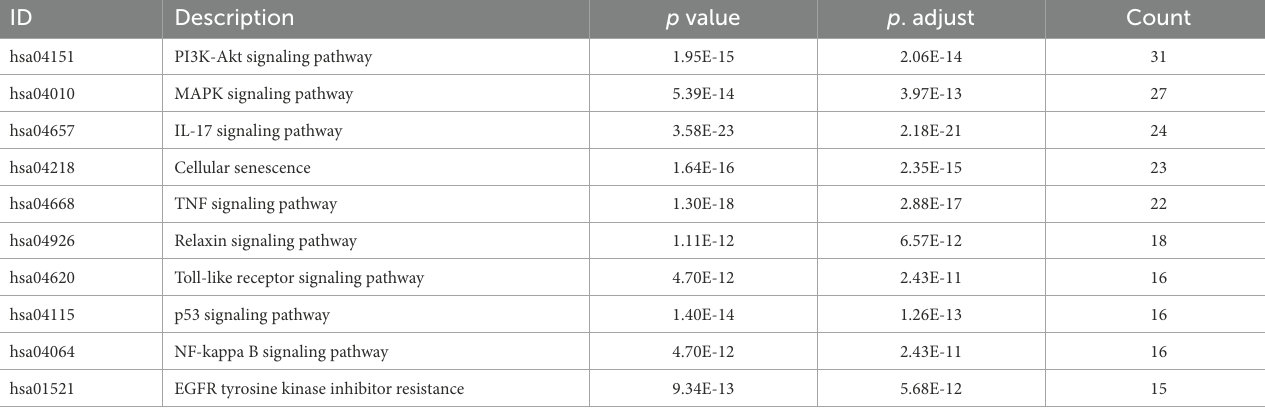
TABLE 3 The enriched 10 possible related pathways for